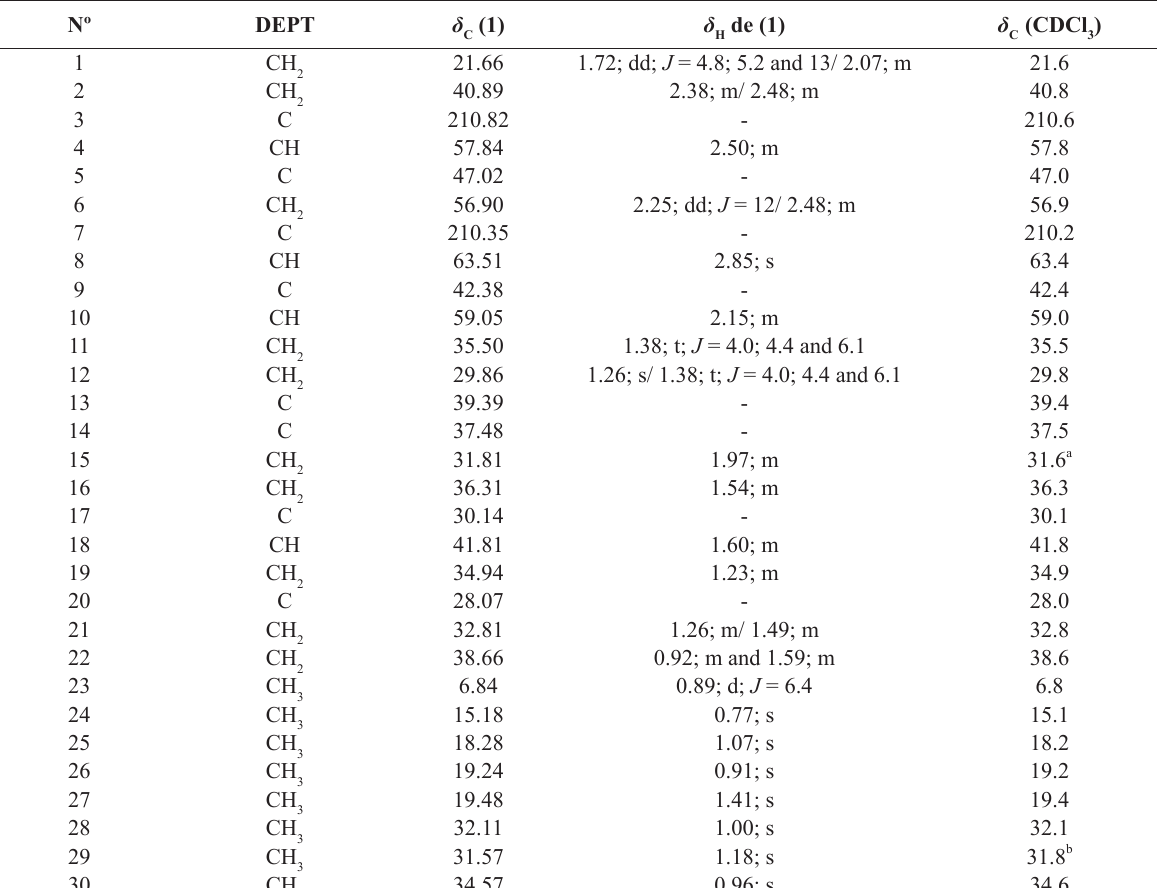
tAble i 1 h and 13 C nMr spectral data of compound 1 in comparison to literature (torres-romero et al.